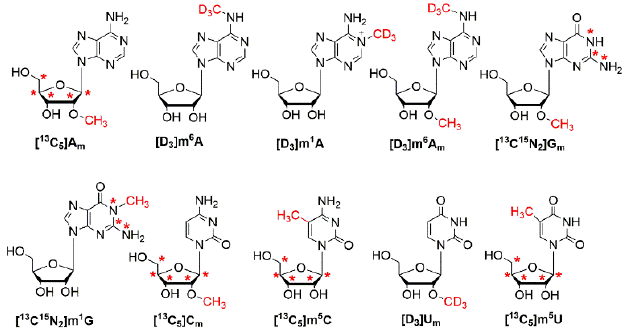
Figure 1. The chemical structures of stable isotope ‐ labeled A m , m 6 A, m 1 A, m 6 A m , G m , m 1 G, C m , m 5 C, U m and m 5 U. Asterisk (*) indicates the site of 13 C or 15 N labeling.